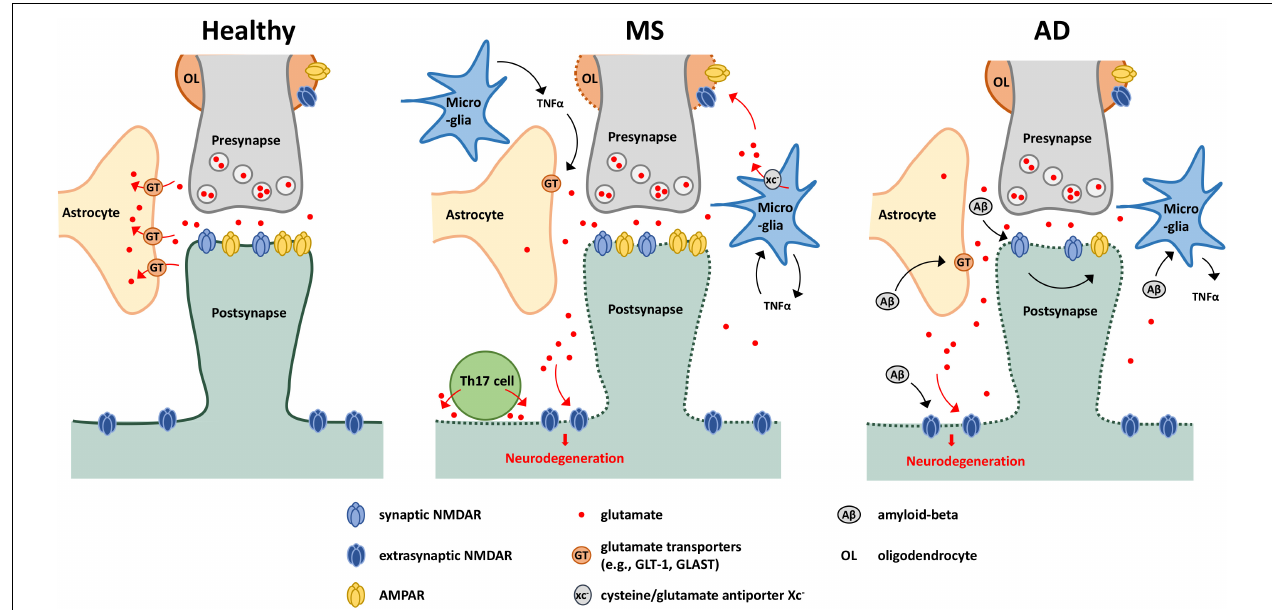
FIGURE 1 | Glutamate-mediated neurodegeneration in MS and AD. Schematic showing possible glutamate-mediated neurodegenerative mechanisms in MS and AD. Under healthy conditions, perisynaptic glutamate levels are maintained through the glutamate cap provided by astrocytes in close proximity of the synapse. Under neuroinflammatory conditions, glutamate spill-over can occur due to downregulation of glutamate transporters, leading to activation of extrasynaptic NMDARs and subsequent neurodegeneration. This downregulation is driven by several effectors including actions of TNF α released by activated microglia or amyloid-beta accumulation. In MS, oligodendrocytes are also sensitive to glutamate excitotoxicity, with glutamate also deriving from activated microglia. Glutamate export is mediated via the cysteine/glutamate antiporter xc - , and is driven in part by a TNF α -mediated autocrine mechanism. Th17 cells have also been shown to release glutamate through the formation of an immuno-neuronal synapse. In AD, amyloid beta can stimulate microglia to produce proinflammatory cytokines such as TNF α , and through interaction with NMDARs, drives AMPAR downregulation (affecting synaptic communication), synapse loss and neuronal